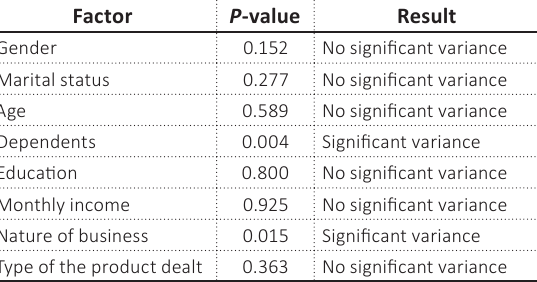
Table 1. Variances to financial stress